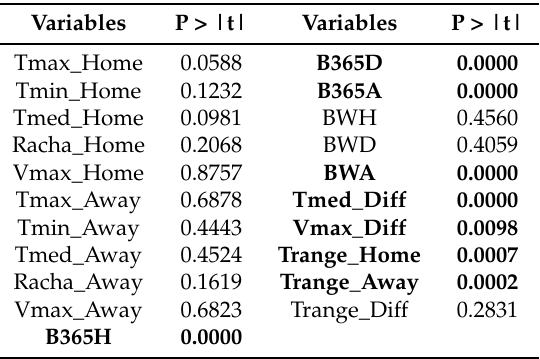
Table 3. Variables and corresponding p -values.